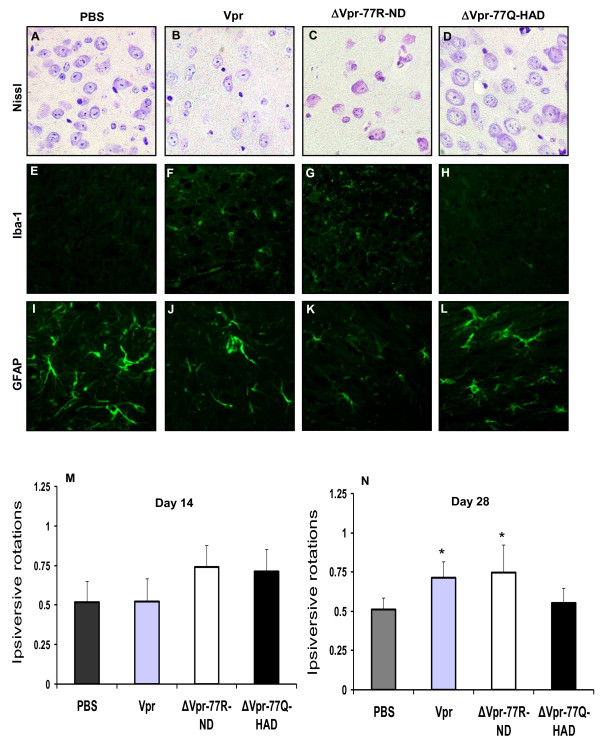
Implanted Vpr and Vpr-derived peptides exert differential effects in vivo. Nissl-stain preparations of ipsilateral basal ganglia (A-D) displayed more neurons in animals implanted with PBS (A) or ΔVpr77Q-HAD (D) compared with full length Vpr (B) or ΔVpr77R-ND (C) implanted animals. Iba-1 immunoreactivity was minimally detected in animals implanted with PBS (E) or ΔVpr77Q-HAD (H) compared with full length Vpr (F) or ΔVpr77R-ND (G) implanted animals, which showed numerous microglia. GFAP immunoreactivity was increased in animals implanted with PBS (I) or ΔVpr77Q-HAD (L) compared with full length Vpr (J) or ΔVpr77R-ND (K) implanted animals. Ipsiversive rotary behaviour fraction (relative to the total number of rotations) did not differ significantly between groups at day 14 post-implant (M) but at day 28 both full length and ΔVpr77R-ND (N) implanted animals showed great ipsiversive rotations. The number of animals used in each experimental group is as follows: PBS group: n = 3; Vpr group: n = 3; ΔVpr-77R-ND group: n = 4; ΔVpr-77Q-HAD group: n = 4 (M-N, Dunnett test, relative to control; *p < 0.05). Original magnification 400×.